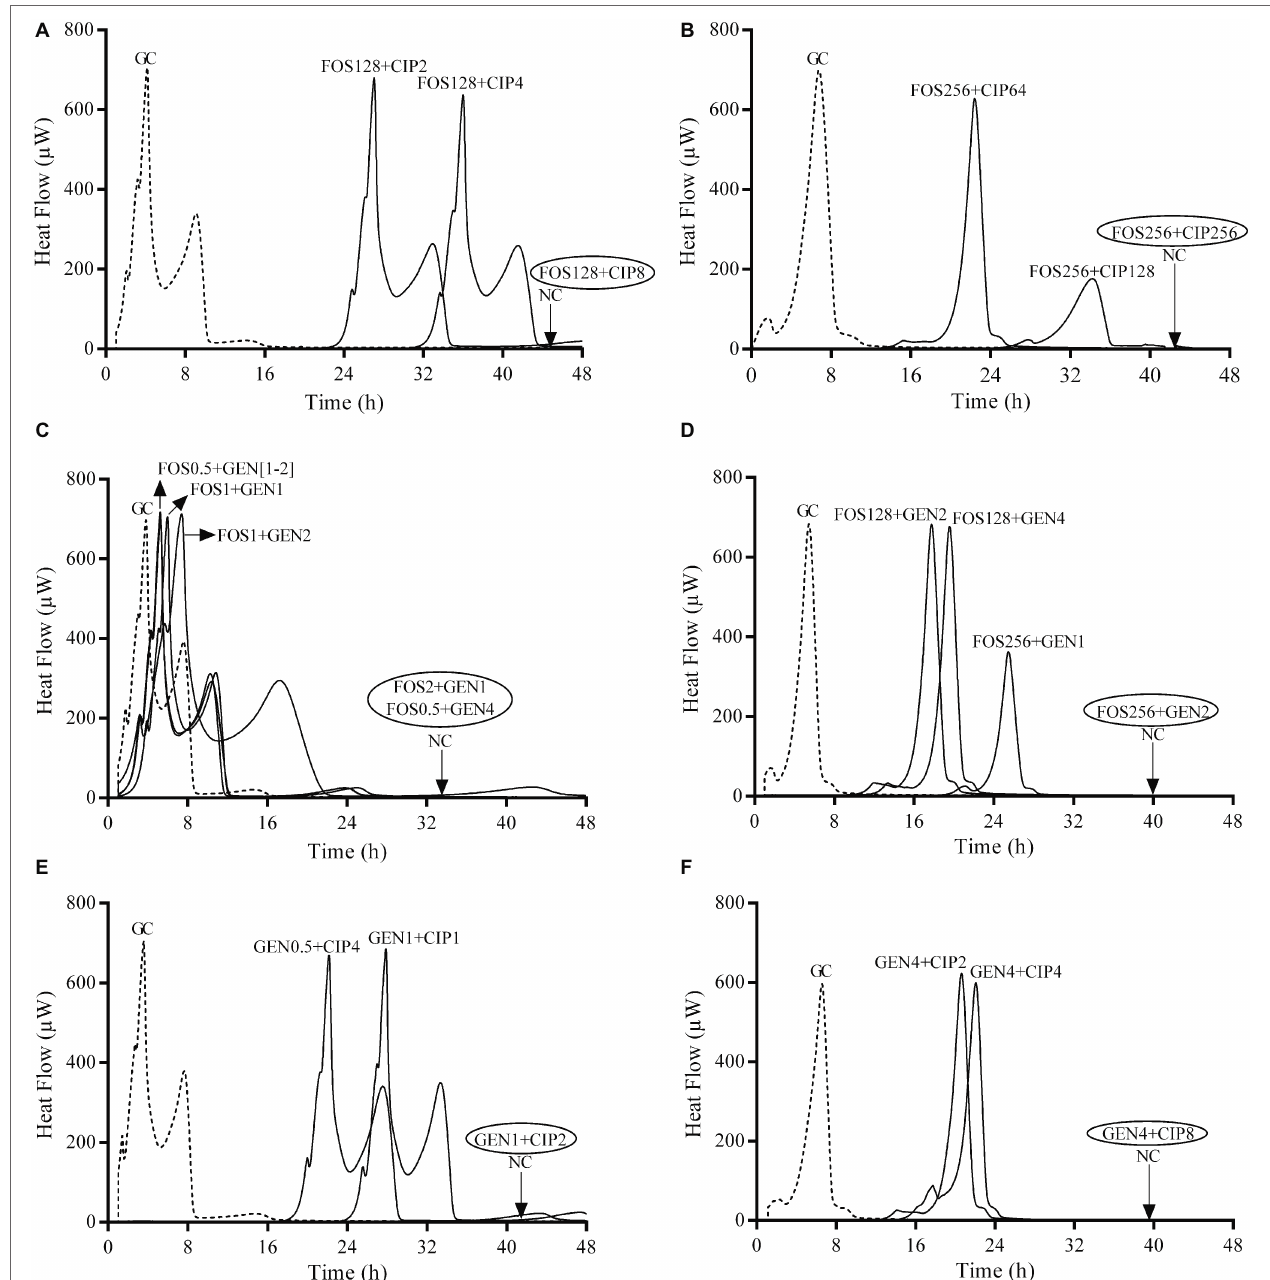
FIGURE 3 | Evaluation of synergistic activity of paired antibiotics by IMC against E. coli ATCC 25922 (A,C,E) and P. aeruginosa ATCC 27853 (B,D,F) biofilms. Numbers represent concentrations (in μg/ml). Circled values represent the MBBC. GC, growth control; NC, negative control; FOS, fosfomycin; GEN, gentamicin; CIP, ciprofloxacin. Data of a representative experiment are